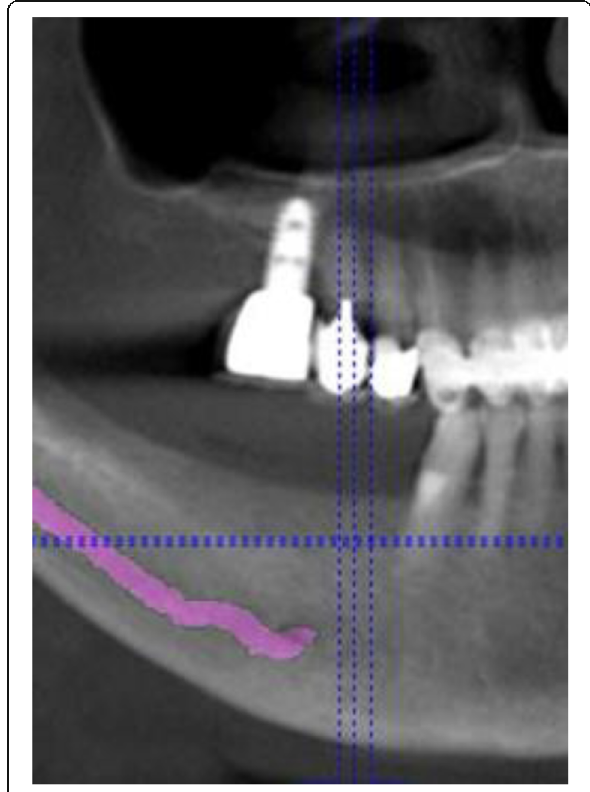
Fig. 8 CBCT for pre-OP surgical planning of an elderly female patient (76 years) with severe horizontal bone deficit in the right mandible with missing teeth 44, 45, 46, and 47. The inferior alveolar nerve is visualized in pink color